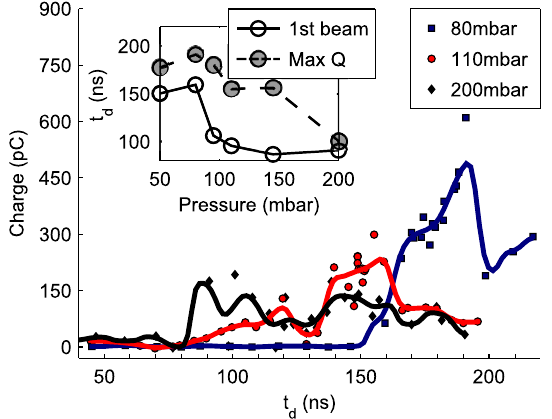
FIG. 2. (Color) Total electron beam charge Q measured on L1 as a function of delay t d for P ¼ 80 , 110, 200 mbar. The solid lines are a moving average using a Gaussian function, defined by e (cid:3) t 2 d =(cid:1) 2 , where (cid:1) ¼ 5 ns . Inset: Delay t d at which electron beams were first observed, and delay at which the highest bunch charge Q was observed, as a function of P